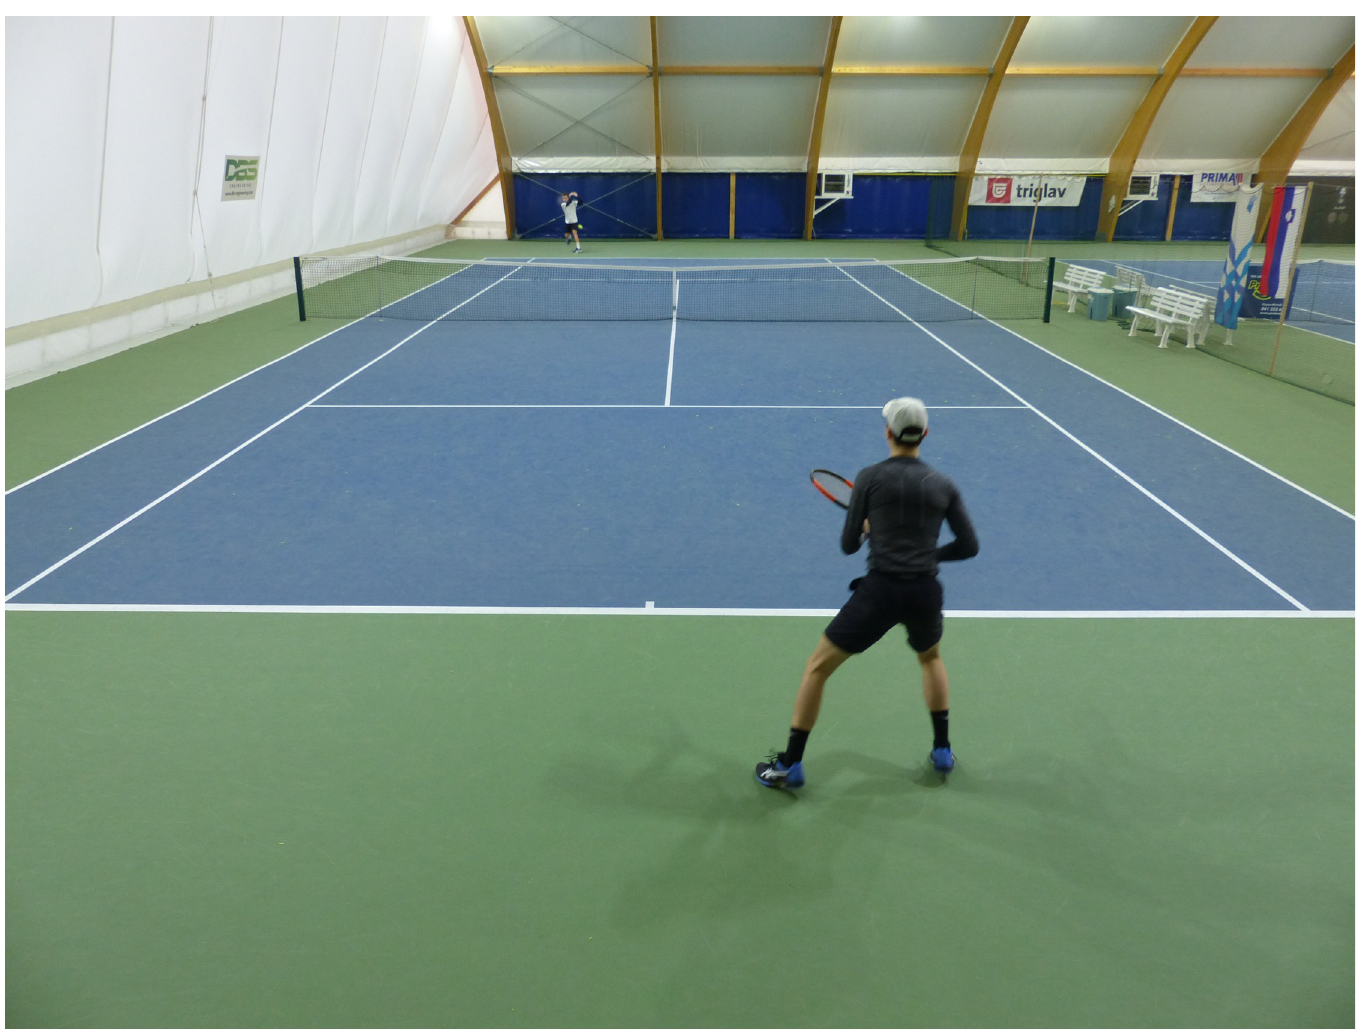
Fig 2. Video camera position during the practice and